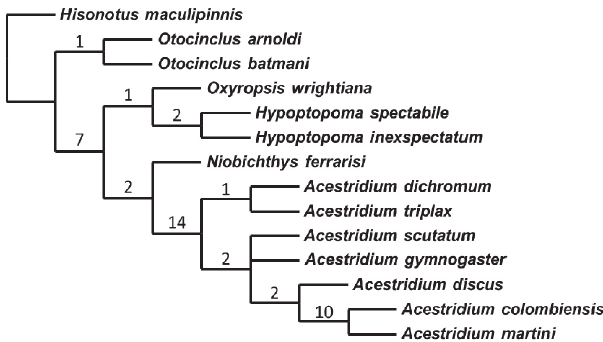
Fig. 9. Strict consensus tree depicting the phylogenetic relationships of the species of Acestridium , based on a maximum parsimony analysis of the unordered and unweighted matrix. Primary trees = 2; Length = 92 steps; Consistency Index = 0.75; Retention Index = 0.87. Numbers above each branch are Bremer decay indices.